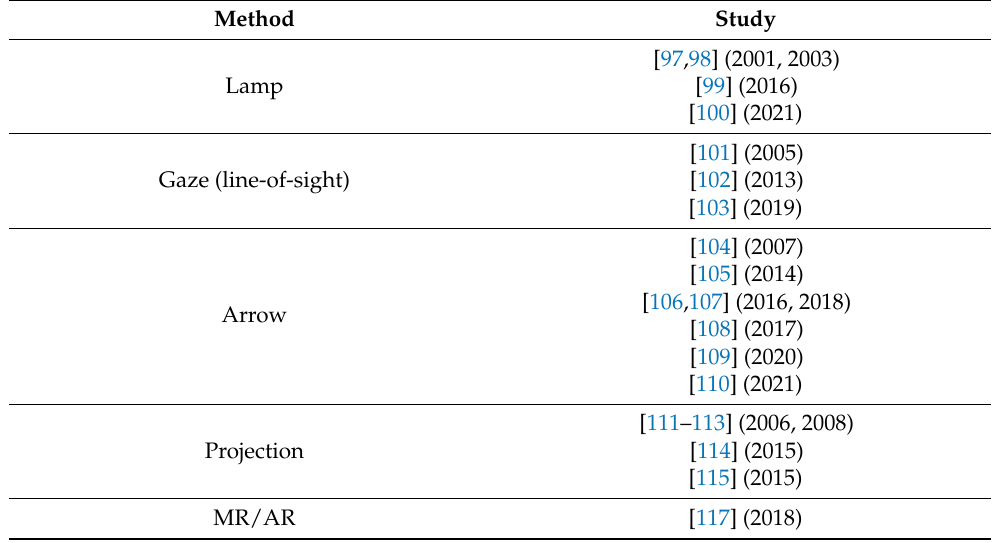
Table 7. Transmission of the movement intentions of